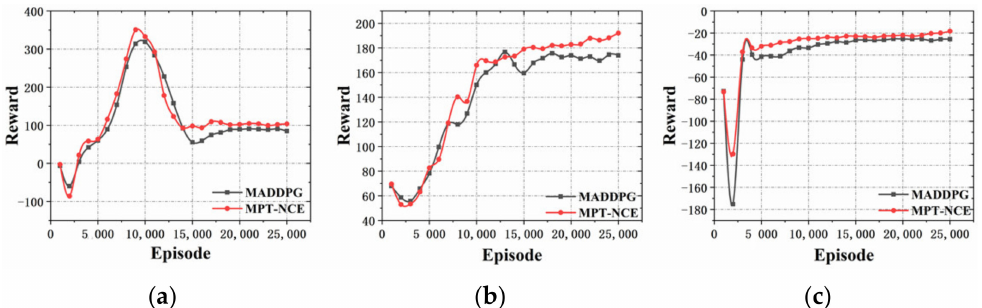
Figure 5. Reward curves in prediction experiment: ( a ) shows the comparison chart of the reward curve between the MPT-NCE method and the MADDPG method. ( b ) shows the blue detection agents’ reward curves of MPT-NCE method and MADDPG method, respectively. ( c ) shows the red interference agents’ reward curves of MPT-NCE method and MADDPG method, respectively.